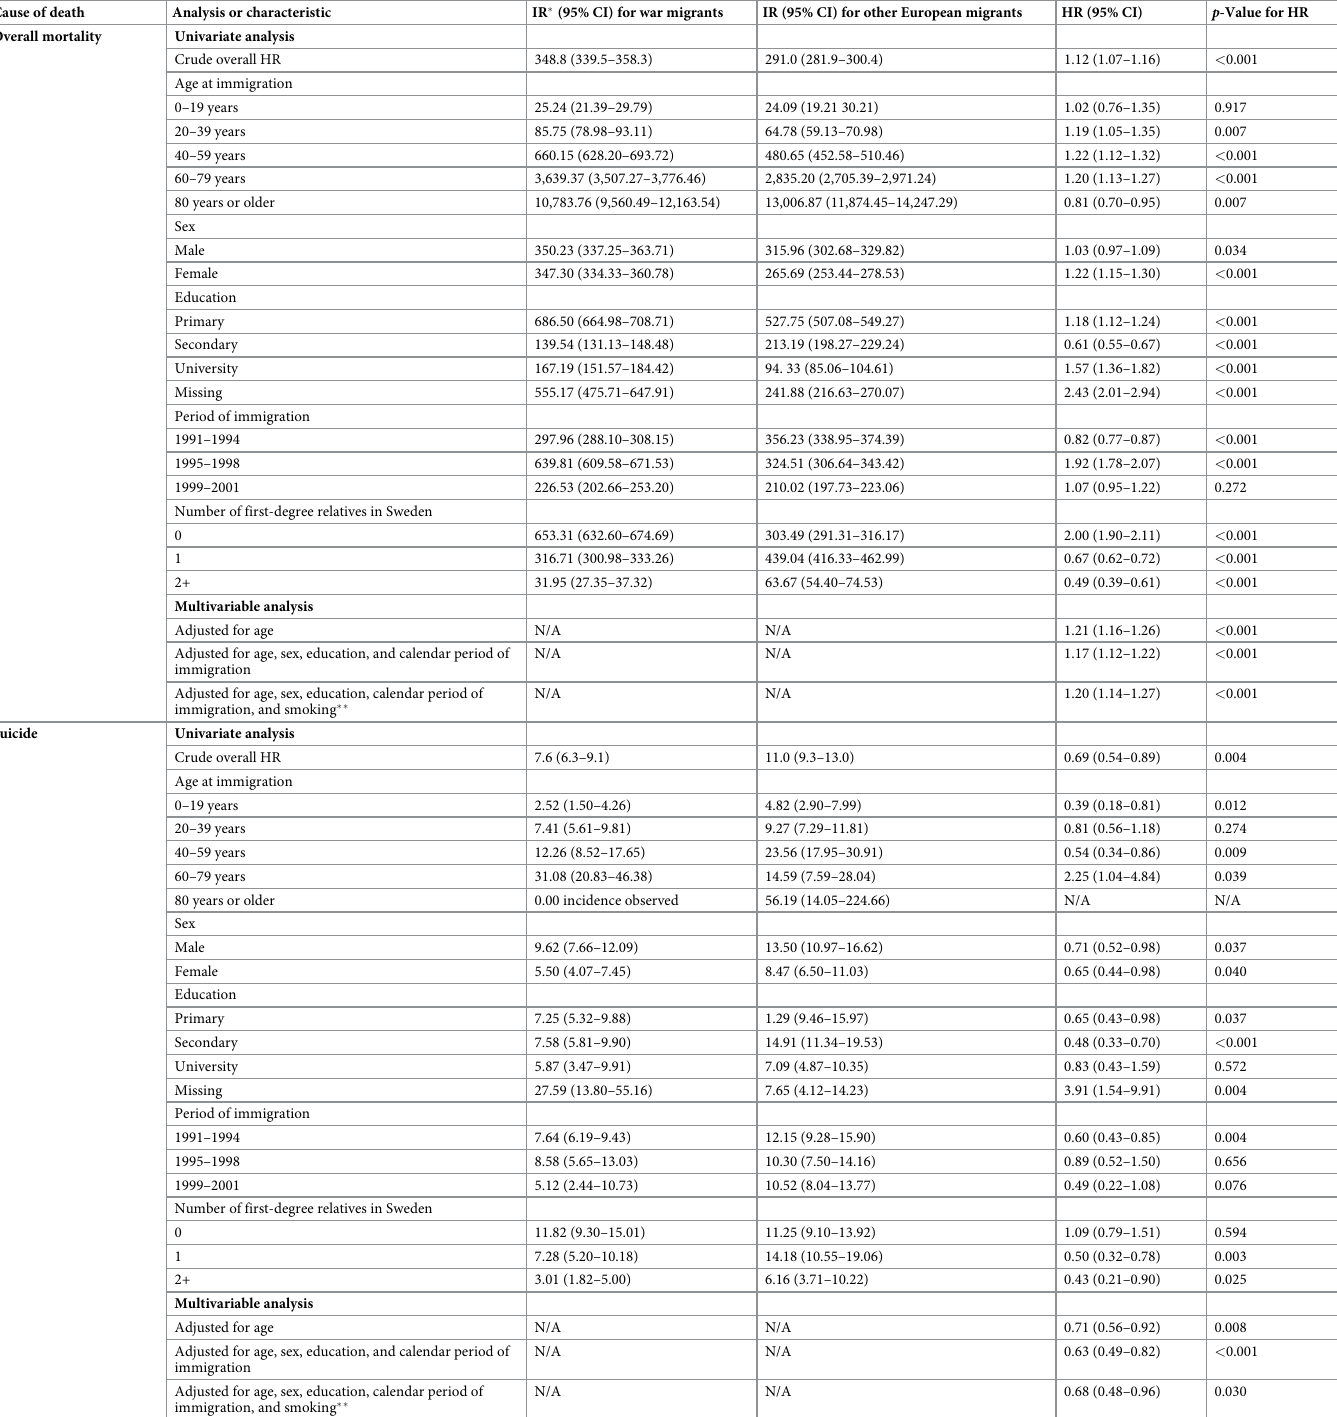
Table 2. Mortality rates in migrants of the Balkan wars compared to other European migrants, across strata of sociodemographic and lifestyle-related characteristics.